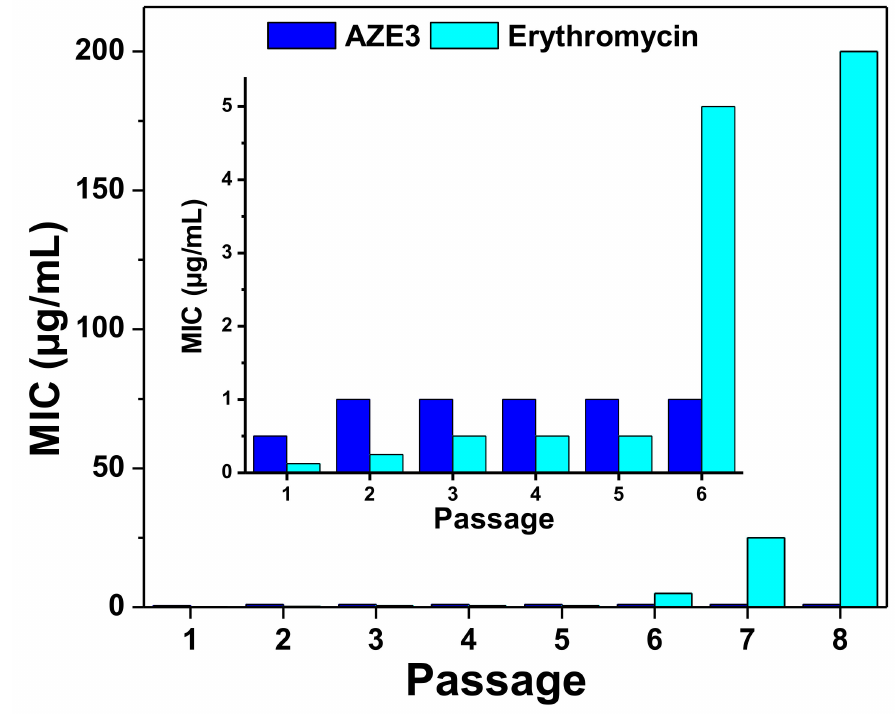
Figure 8. Development of drug resistance. Antibacterial profiles of AZE3 and erythromycin against S. aureus cells after multiple treatments ( n = 8) at sub-lethal concentrations. Inset shows the enlarged portion form passage 1–6.